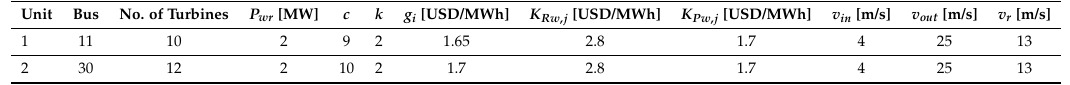
Table A2. Data of wind power plant for IEEE 30-bus Modified (1).